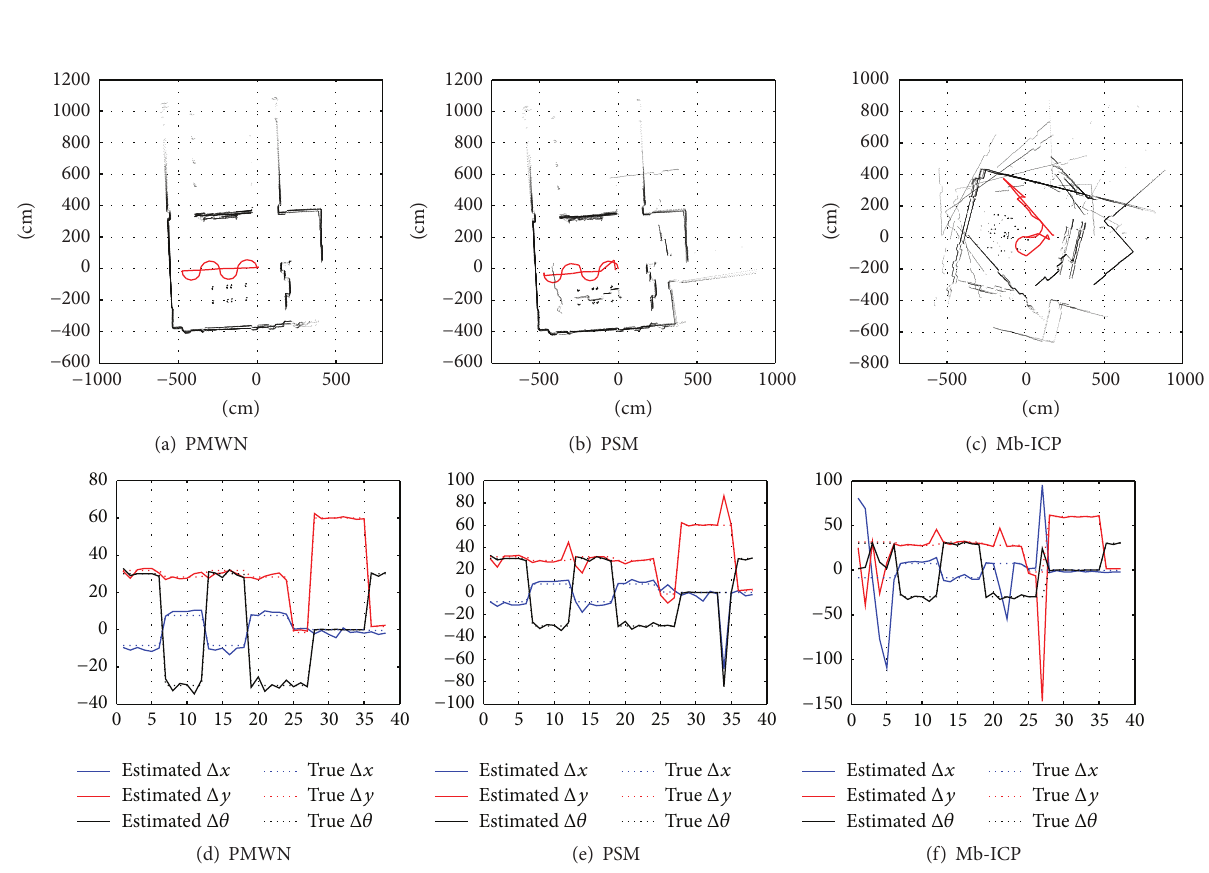
Figure 17: Experiment in the hall using Series 2 path. ((a), (b), and (c)) The laser sensor is continually placed on footprints of Serial 2 path using PMWN, PSM, and Mb-ICP, respectively, to map the hall. ((d), (e), and (f)) Compare the pose estimation of PMWN, PSM, and Mb-ICP, respectively, with the true pose in Series 2 path in the